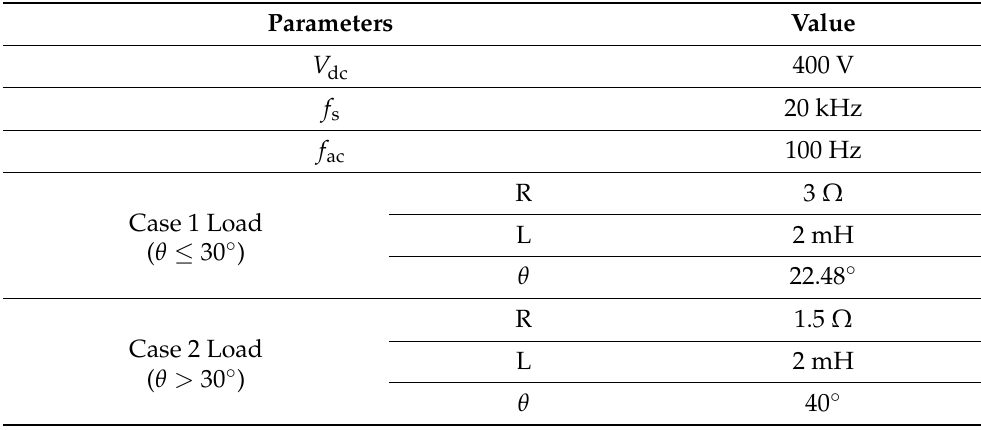
Table 2. System parameters of the three-phase VSI used for simulation.